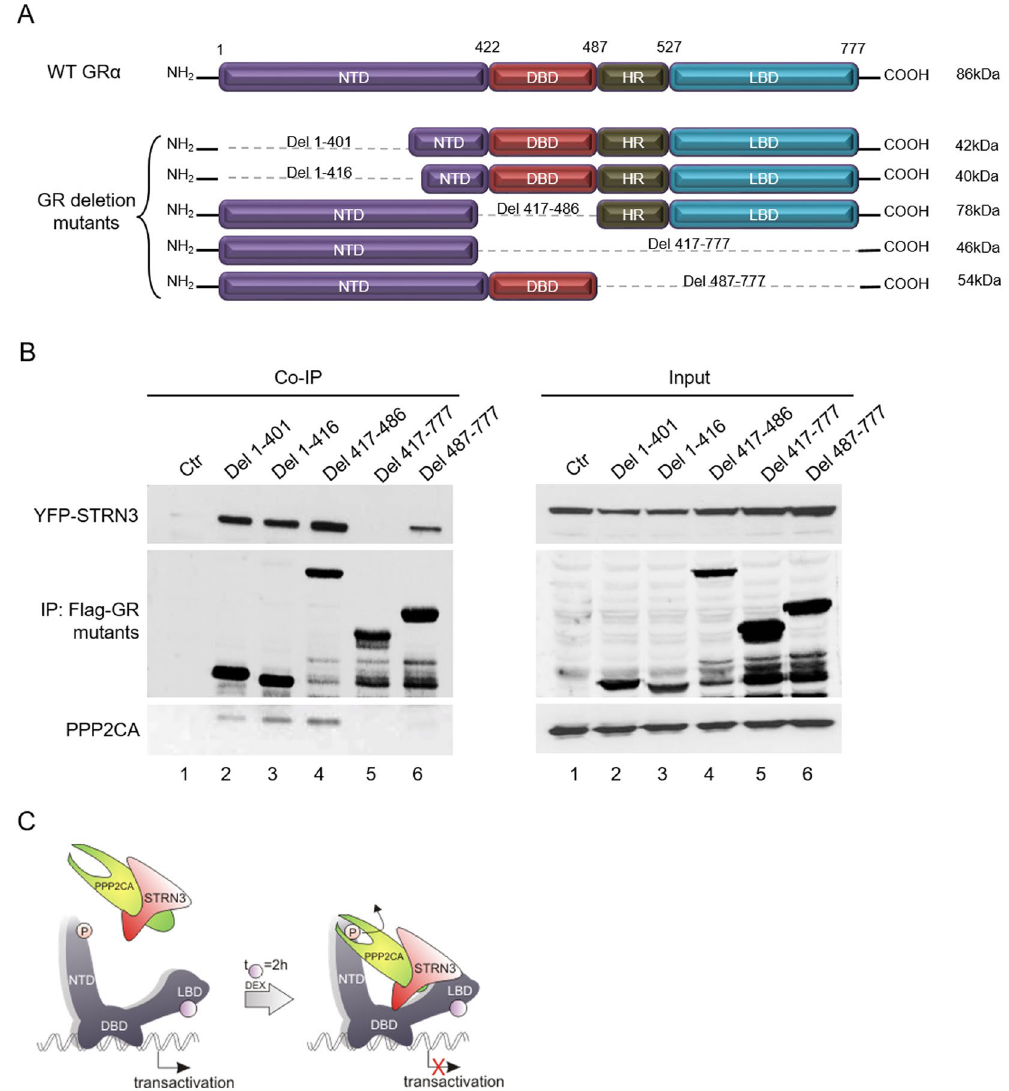
Figure 8. The formation of the trimeric complex GR/STRN3/PPP2CA is dependent on the ligand-binding domain of GR. ( A ) Representation of the GR deletion mutants that were used for mapping GR domains important for the formation of the trimeric complex. ( B ) HEK293T cells were transfected in 10 cm plates with 3 μ g of the different Flag-GR deletion mutants along with 4 μ g of YFP-STRN3 (122 kDa). 48 h post-transfection the cells were lysed and processed for co-immunoprecipitation with M2-Flag beads (7 μ g of total DNA was transfected per plate). The resulting complexes were analyzed with gel electrophoresis and immunoblotting using antibodies against Flag, STRN3 and PPP2CA. In this experiment PPP2CA was not over-expressed and we rely on the endogenous PPP2CA binding to the complex. This is a representation of a series of triplicate experiments that all yielded similar results (full-length blots are provided in Supplementary S18). ( C ) Proposed model for the formation of the trimeric GR-STRN3-PPP2CA complex. GR LBD (and to a lesser extent GR DBD) binds STRN3, allowing PPP2CA to be recruited and to dephosphorylate GR, leading to hampered transactivation. GR with its protein domains (NTD, DBD, LBD) is depicted in grey. P stands for phosphorylated S211. The purple circle represents the ligand,